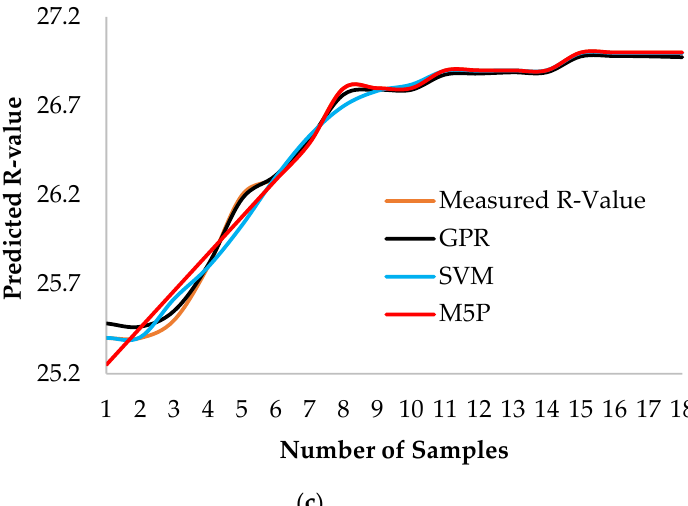
Figure 4. Line graphs showing accuracy of predicted R-value of different models in ( a ) training set, ( b ) testing set, and ( c ) validation set. Table 4. Comparison of statistical parameters for performance evaluation of the GPR, SVM, M5P, and ANN models.